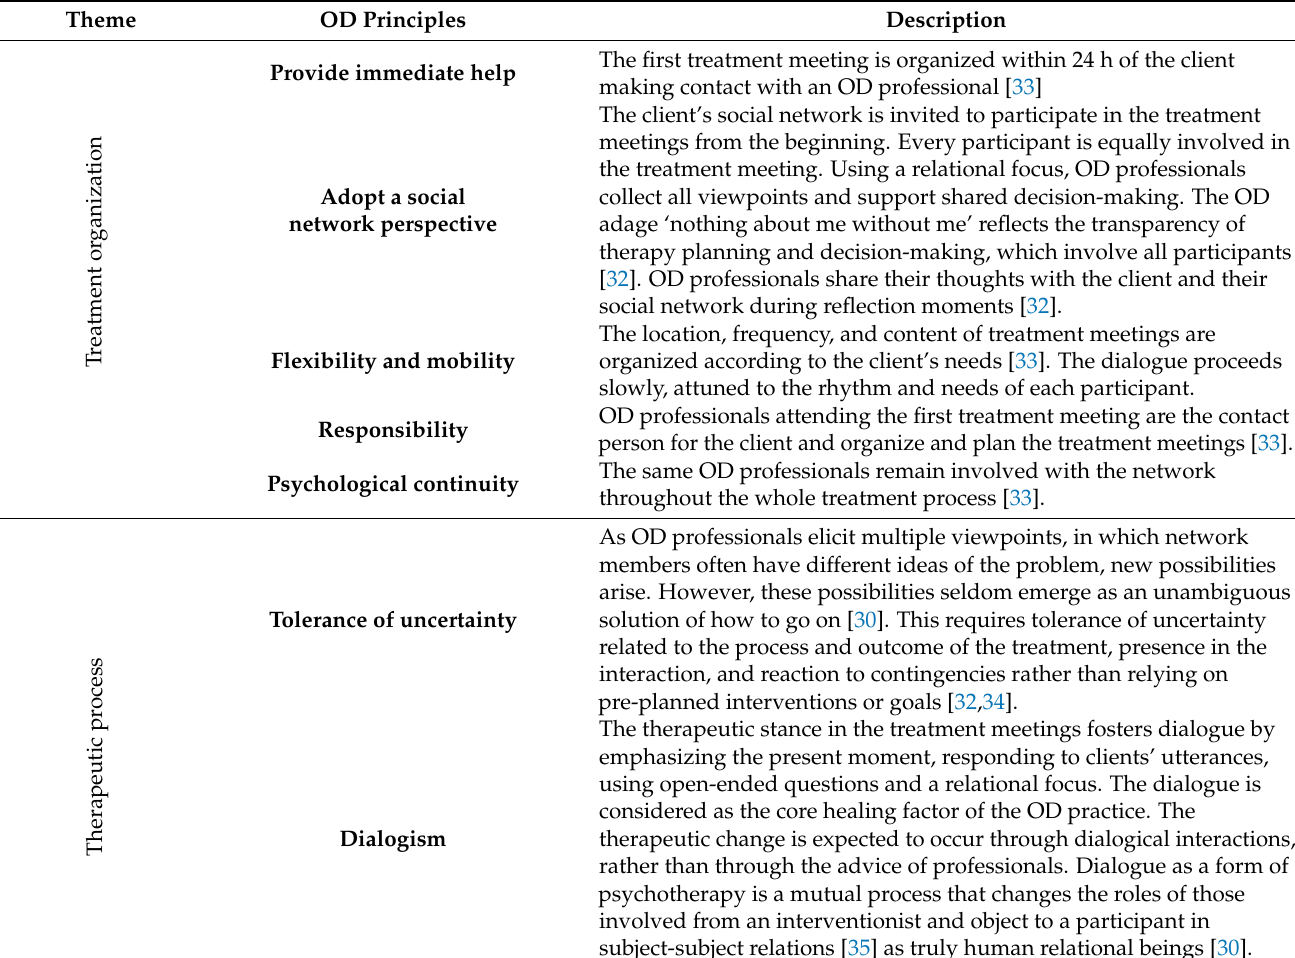
Table 1. Description of the seven OD